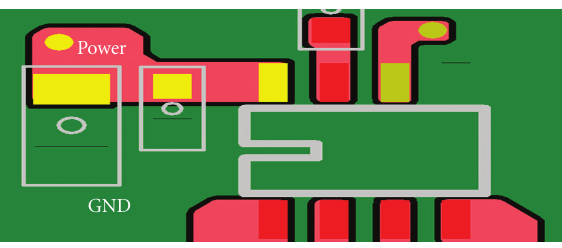
Figure 9: Decoupling capacitor configuration.